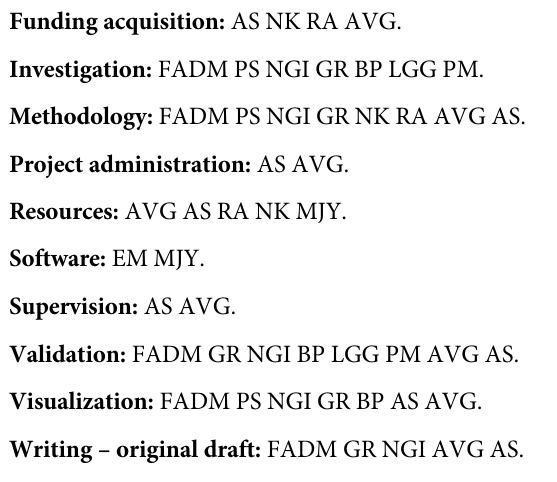
S4 Table. List of oligonucleotides